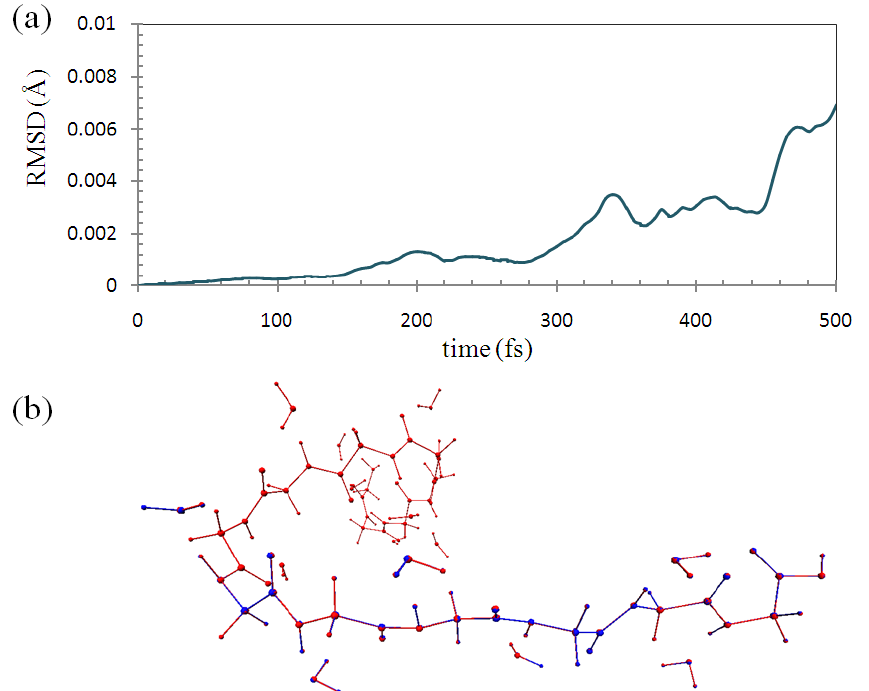
ELG-MD and conventional ab initio MD with fixing of the same atoms; ( b ) Superimposed structures at 500 fs. (Red: conventional AIMD. Blue: